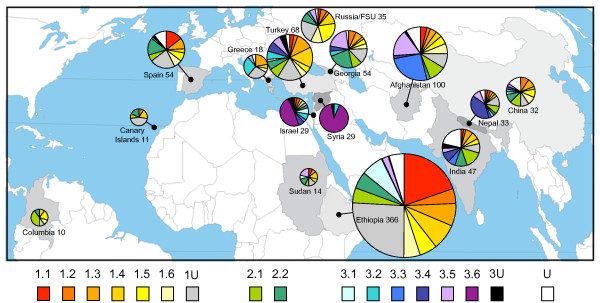
Geographical Distribution of Structure Sub-Groups of the JIC Pisom Germplasm. Data are shown for all donor countries contributing 10 or more accessions in the JIC Pisum Collection. Each piechart refers to a single country, the area of the piechart reflects the number of accessions derived from that country and the corresponding compositions by Structure Sub-Group (colour-coded as in Figures 4-6) are indicated. The map is derived from [41].